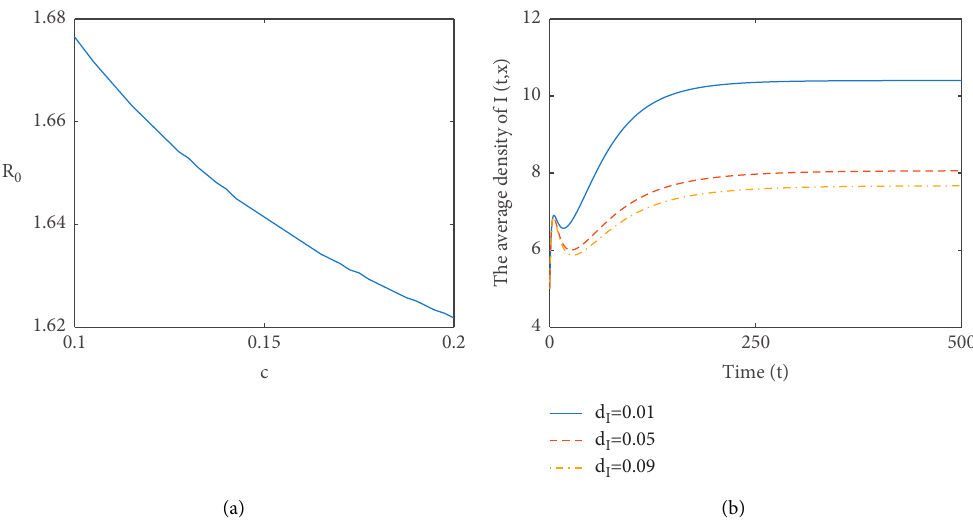
Figure 2: The influence of diffusion rate on infected individuals. (a) d